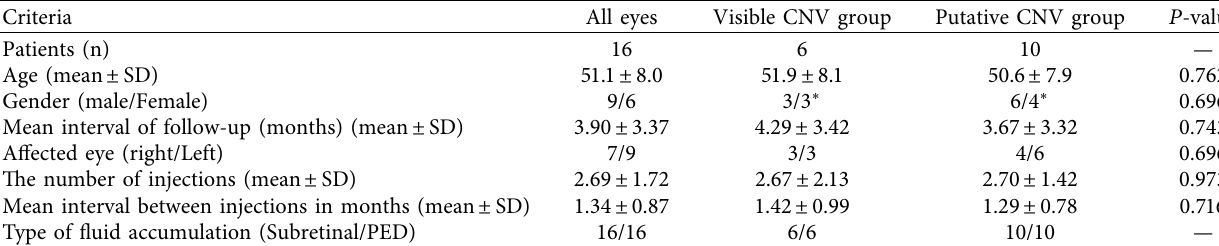
Table 1: Baseline characteristics of all eyes included in the